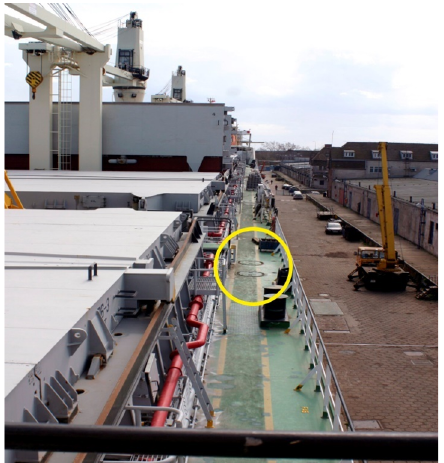
Figure 2. The main deck and tank inspection manhole covers for ballast tanks.